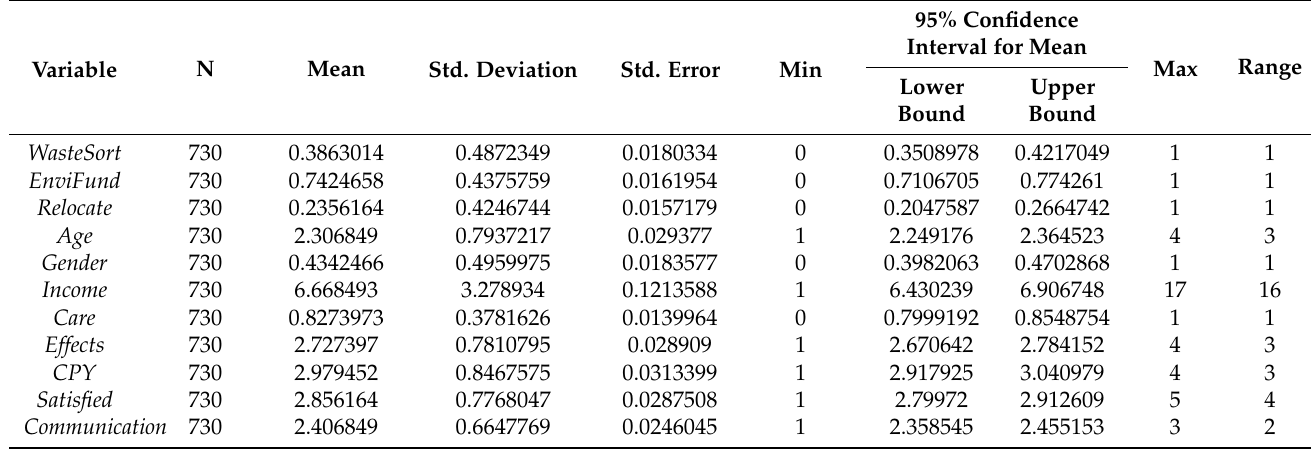
Table 2. Descriptive